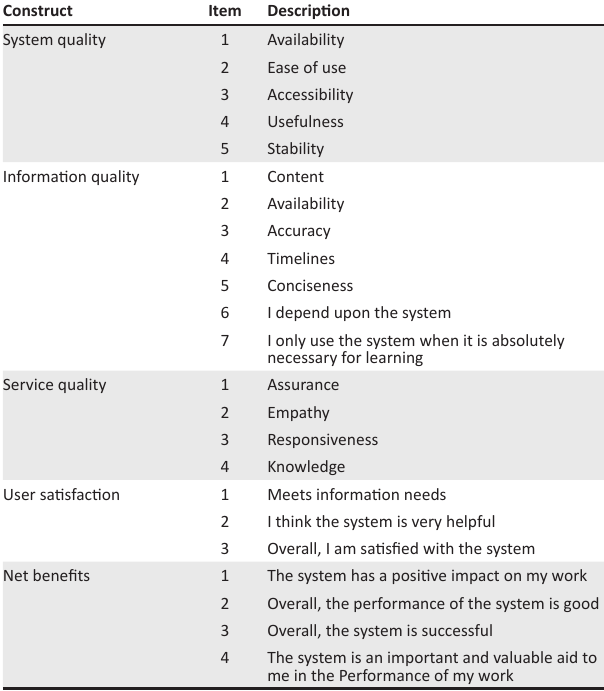
FIGURE 1: Conceptual framework for successful Business Intelligence System implementation. TABLE 1: Survey instrument constructs.